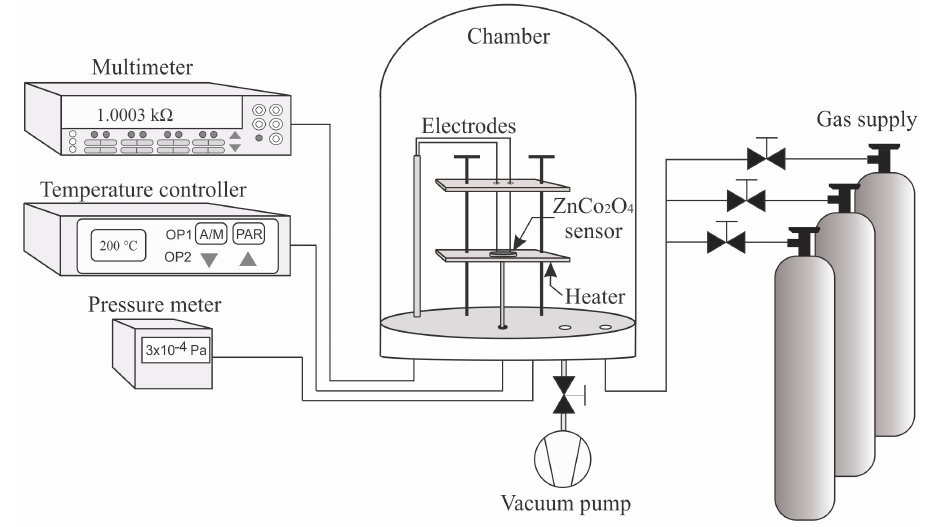
Figure 1. Experimental setup for the gas sensitivity measurements of ZnCo 2 O 4 nanoparticles.